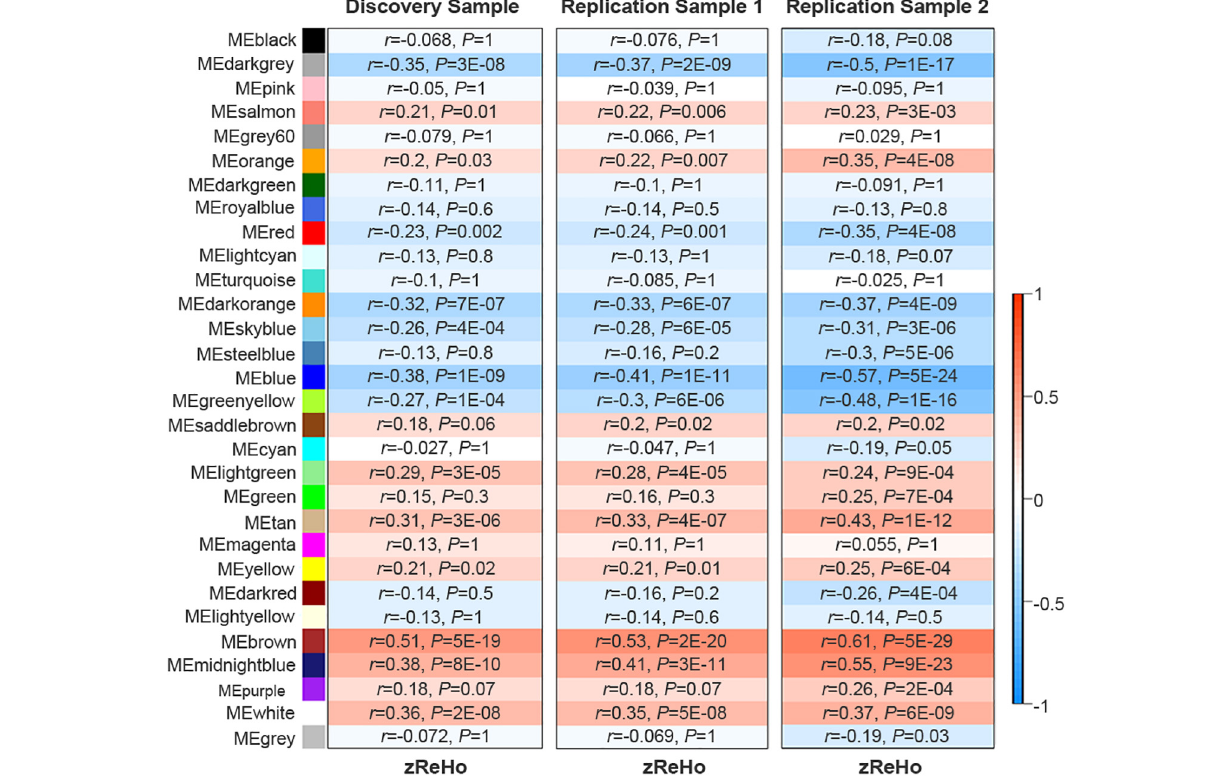
inner membrane ( q c = 3.2 × 10 − 3 ) ( Figure 5E ).